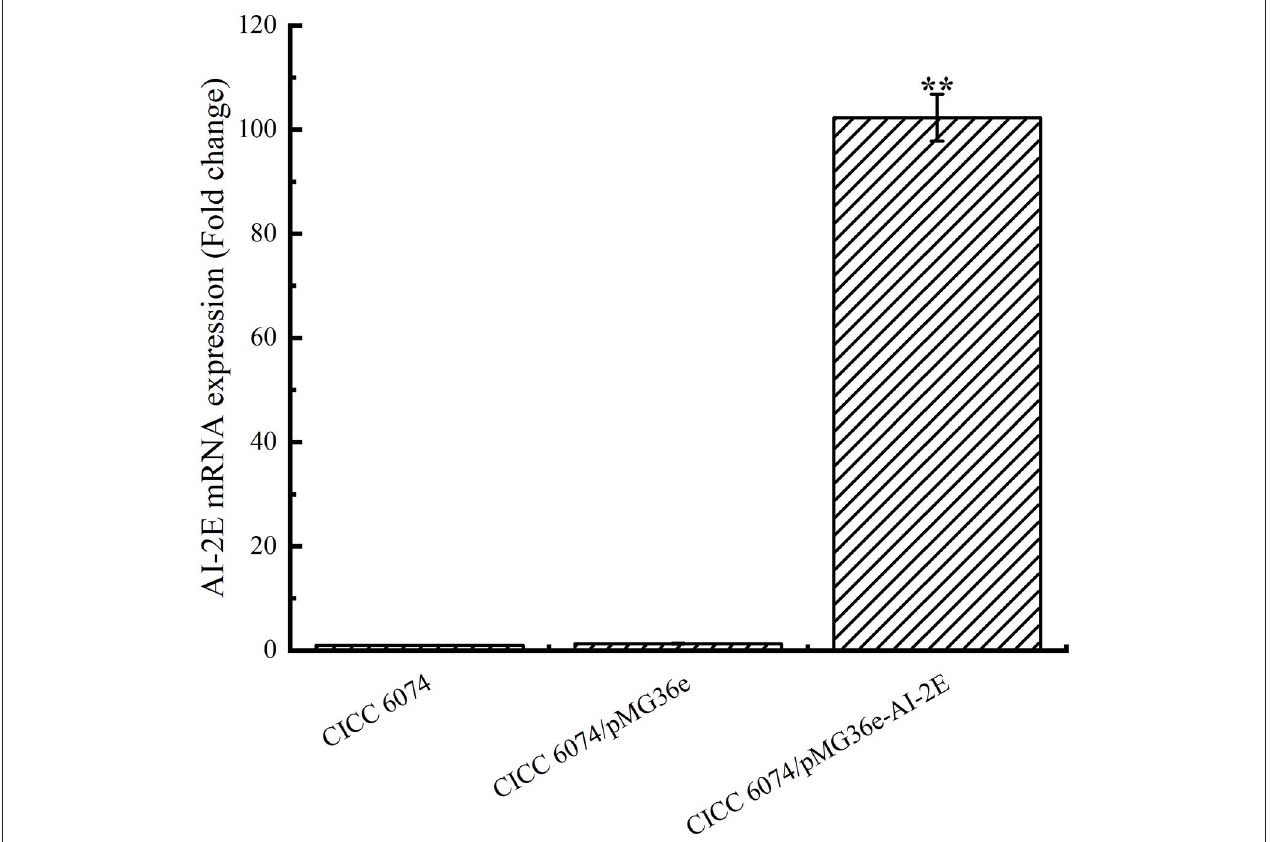
FIGURE 5 | AI-2E gene mRNA expressions of Lactobacillus acidophilus CICC 6074 wild-type strain, L. acidophilus CICC 6074/pMG36e recombinant strain, and L. acidophilus CICC 6074/pmG36e-AI-2E recombinant strain. Data are presented as mean ± SEM; n ≥ 3; ** p < 0.01 compared with the wild-type strain.